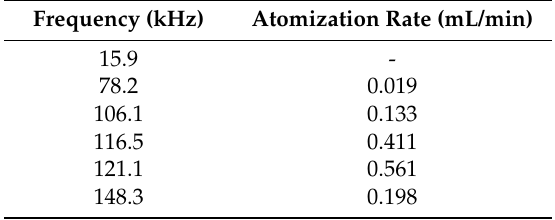
Figure 10. Frequency sweep curves of the vibration velocity and amplitude, vibration modes of resonance points, and atomization rates at the resonance points. Table 3. Resonant frequencies and atomization rates of each resonant frequencies under an applied voltage of 70